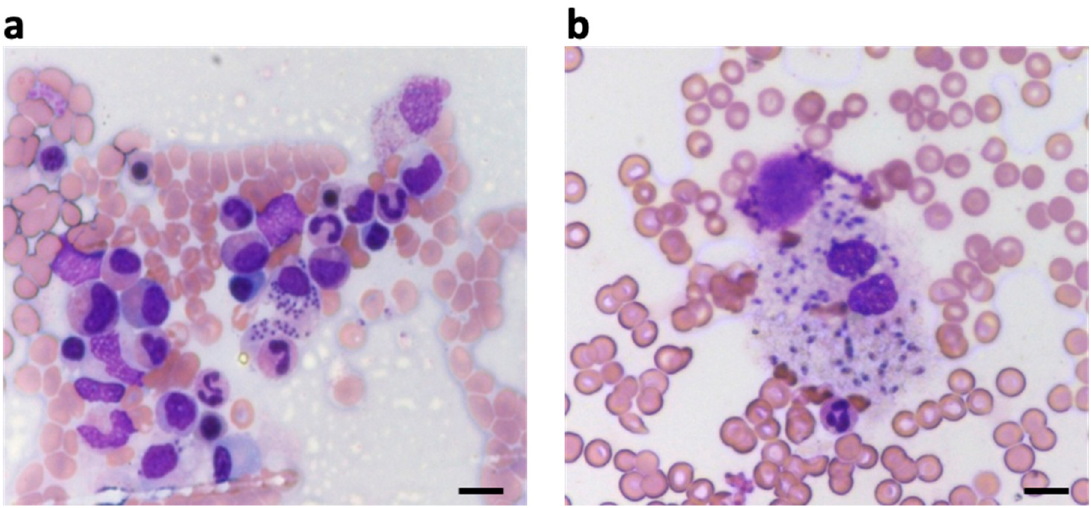
Figure 3. Light-microscopic examination of an M-Giemsa-stained bone marrow specimen showing macrophages containing multiple Leishmania amastigotes. ( a , b ) Representative images of Leishmania amastigotes at different magnifications have been shown. ( a ) Original magnification ×1000, scale bar = 15 μ m. ( b ) Original magnification ×1000, scale bar = 15 μ m. Microscopical evidence was confirmed by serological positivity to anti-Leishmania antibodies (IgG 27.3 NTU vs. a normal value of <11 NTU).